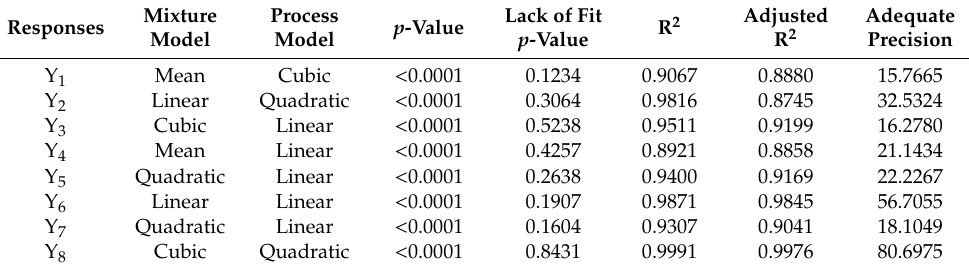
Table 3. Summary of fitted model and statistical